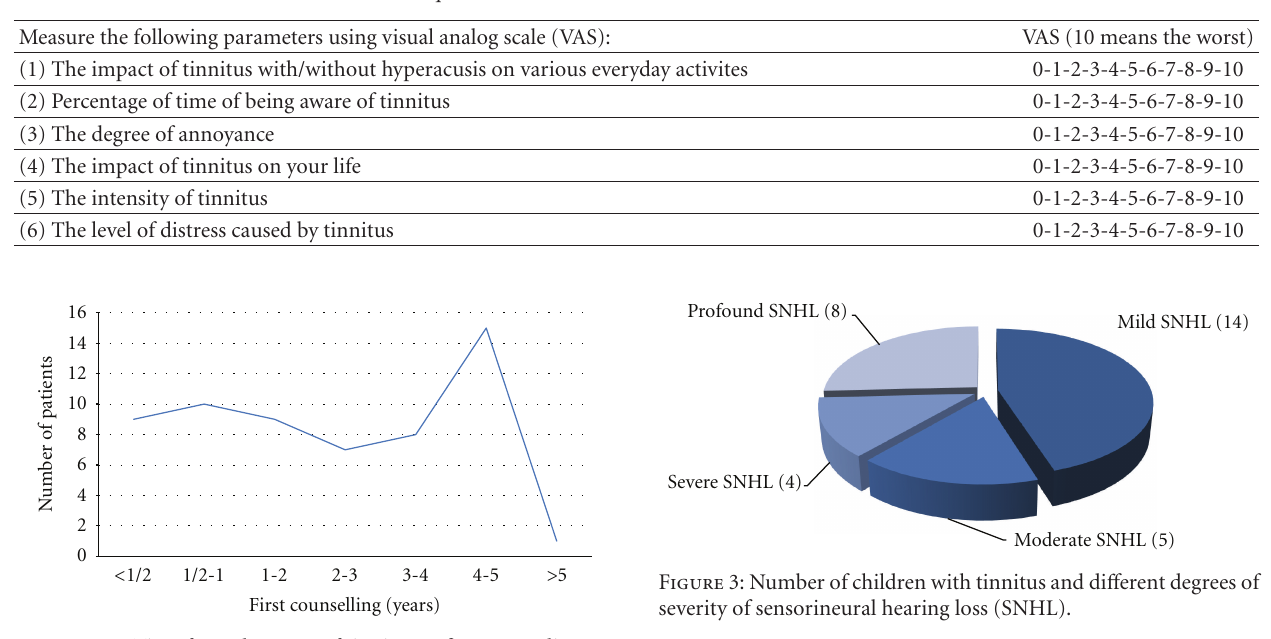
Figure 1: Time from the onset of tinnitus to first counseling.